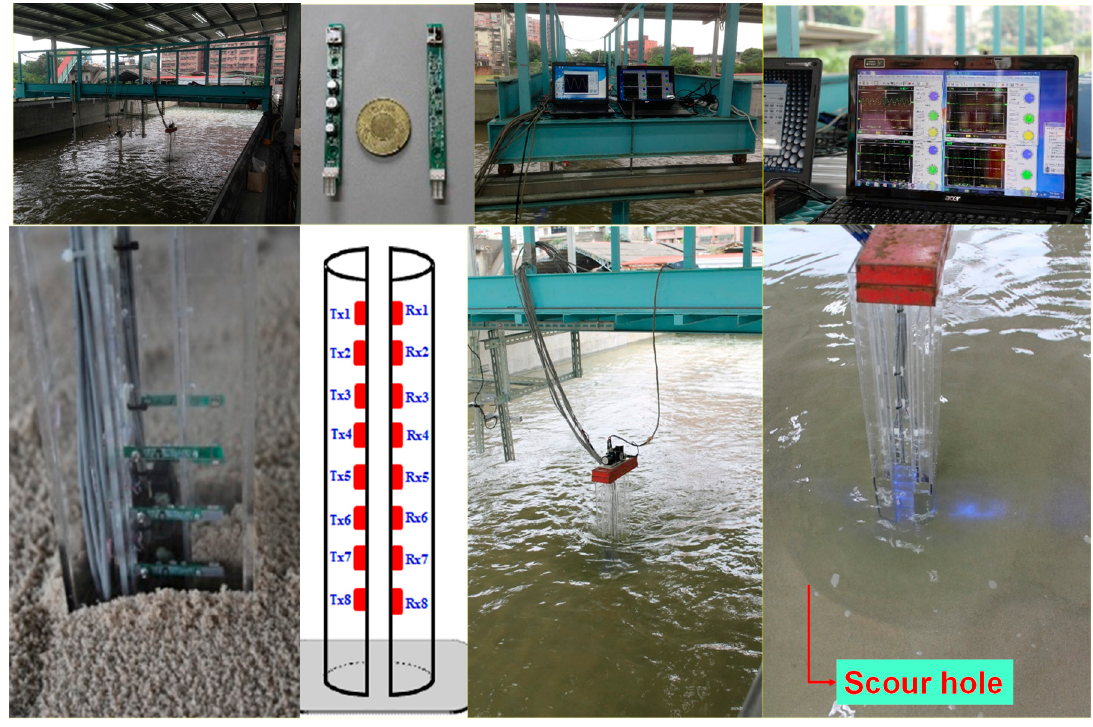
Figure 5. Hydraulic flume test and experimental setup.